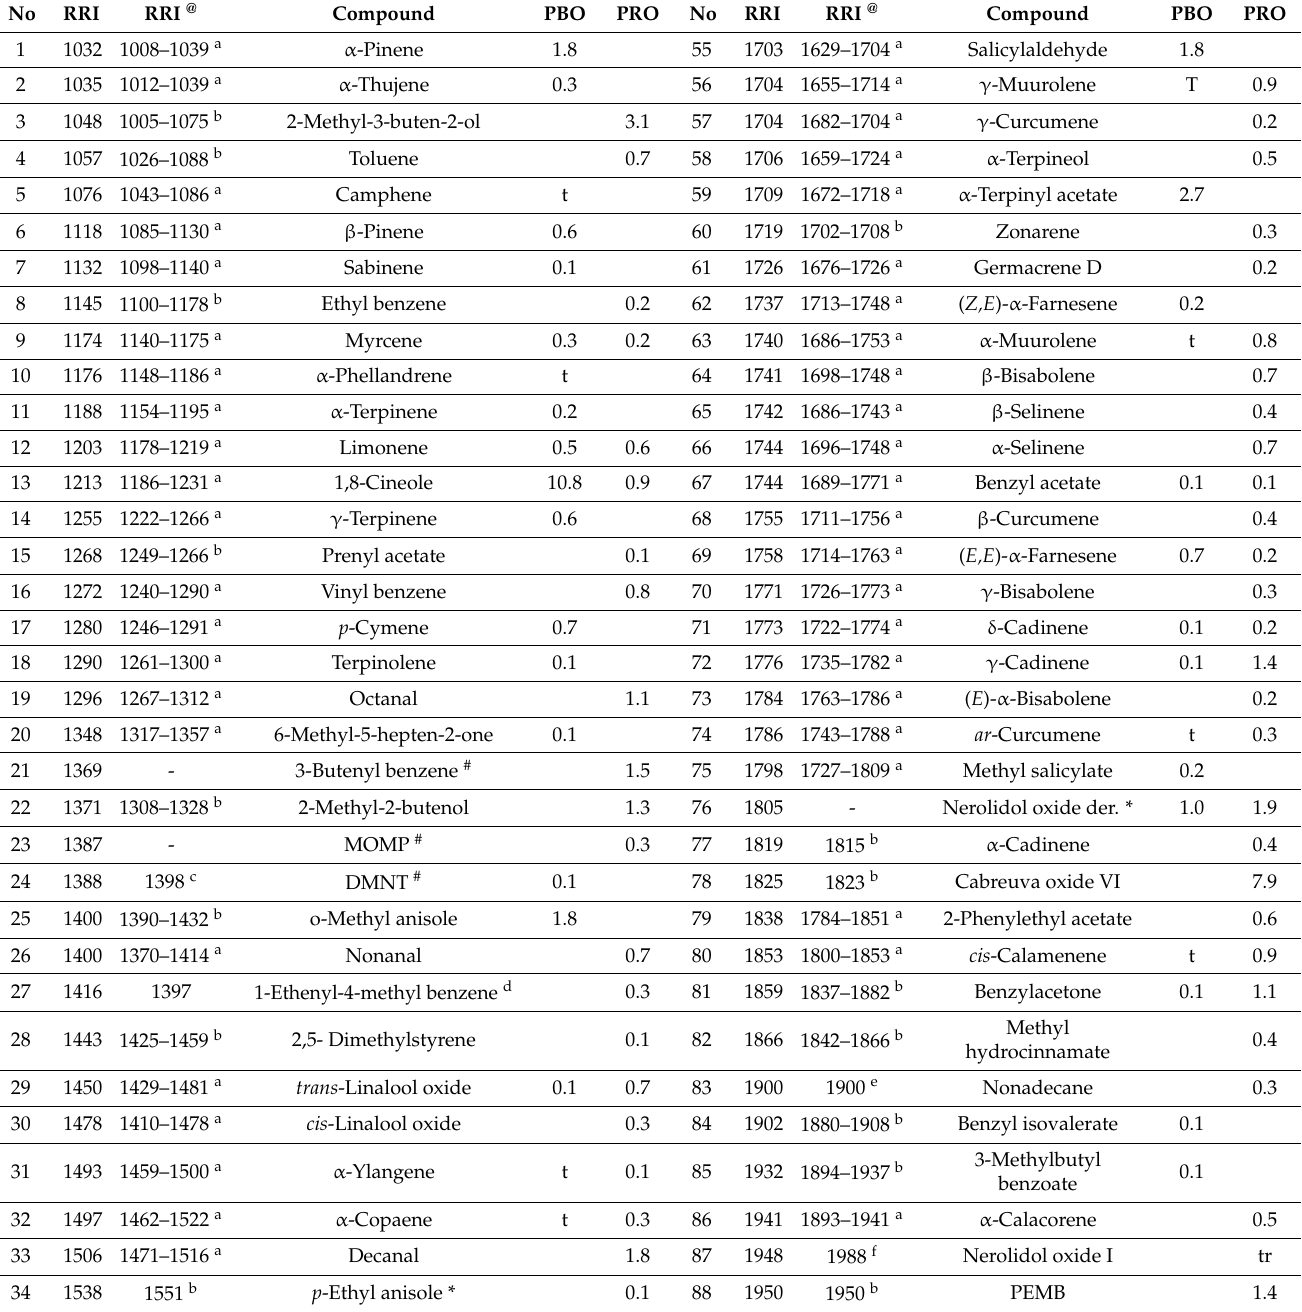
Table 1. Chemical composition of essential oil (%) isolated from P. balsamifera buds (PBO) and propolis